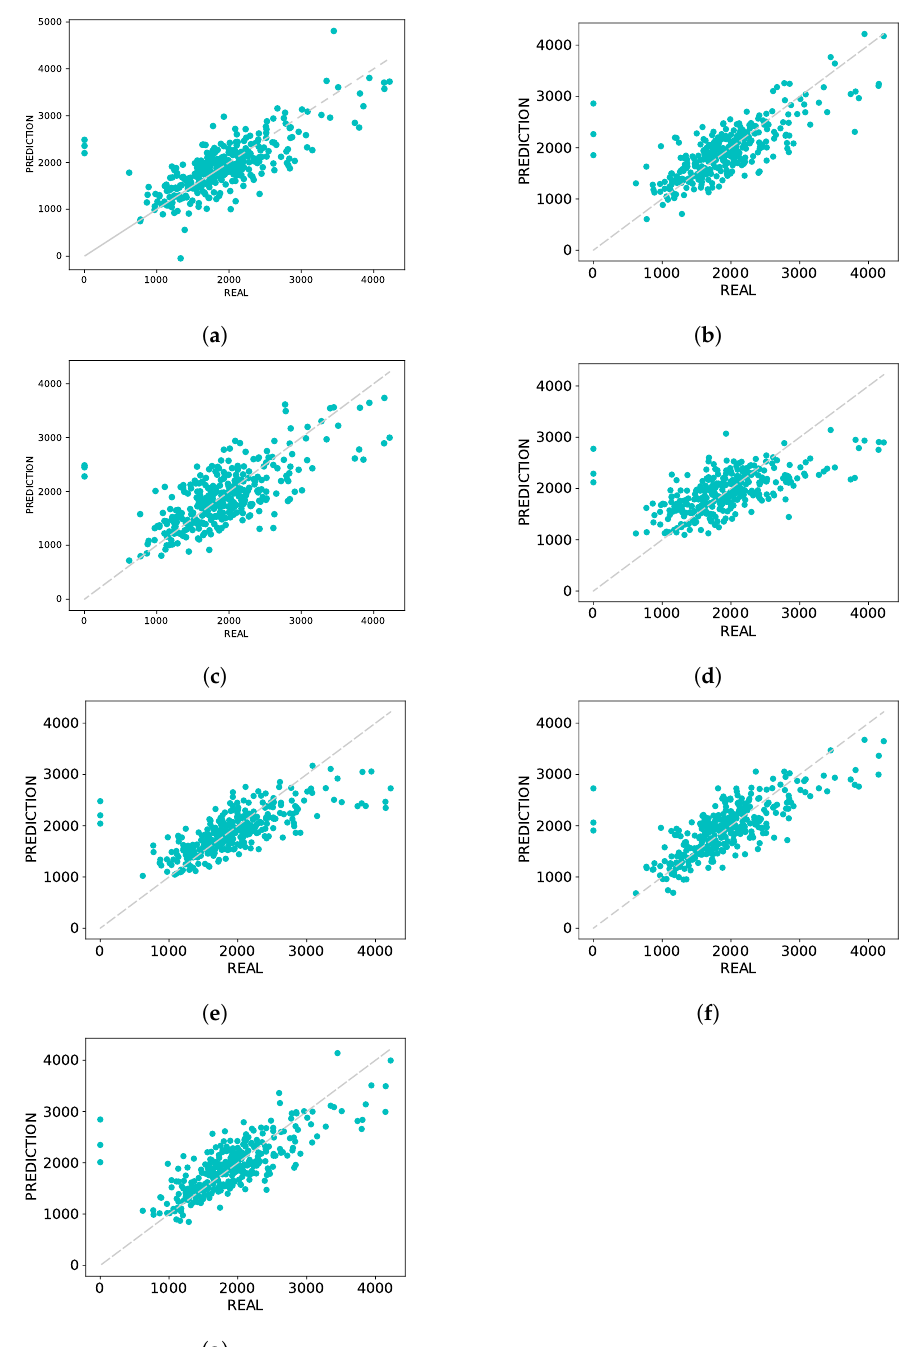
Figure 5. Predicted vs. Real plots-TDMY. ( a ) AlexNet; ( b ) AlexNet pretrained; ( c ) MaCNN; ( d ) LF- CNN; ( e ) ResNeXt50; ( f ) ResNeXt50 pretrained; ( g )